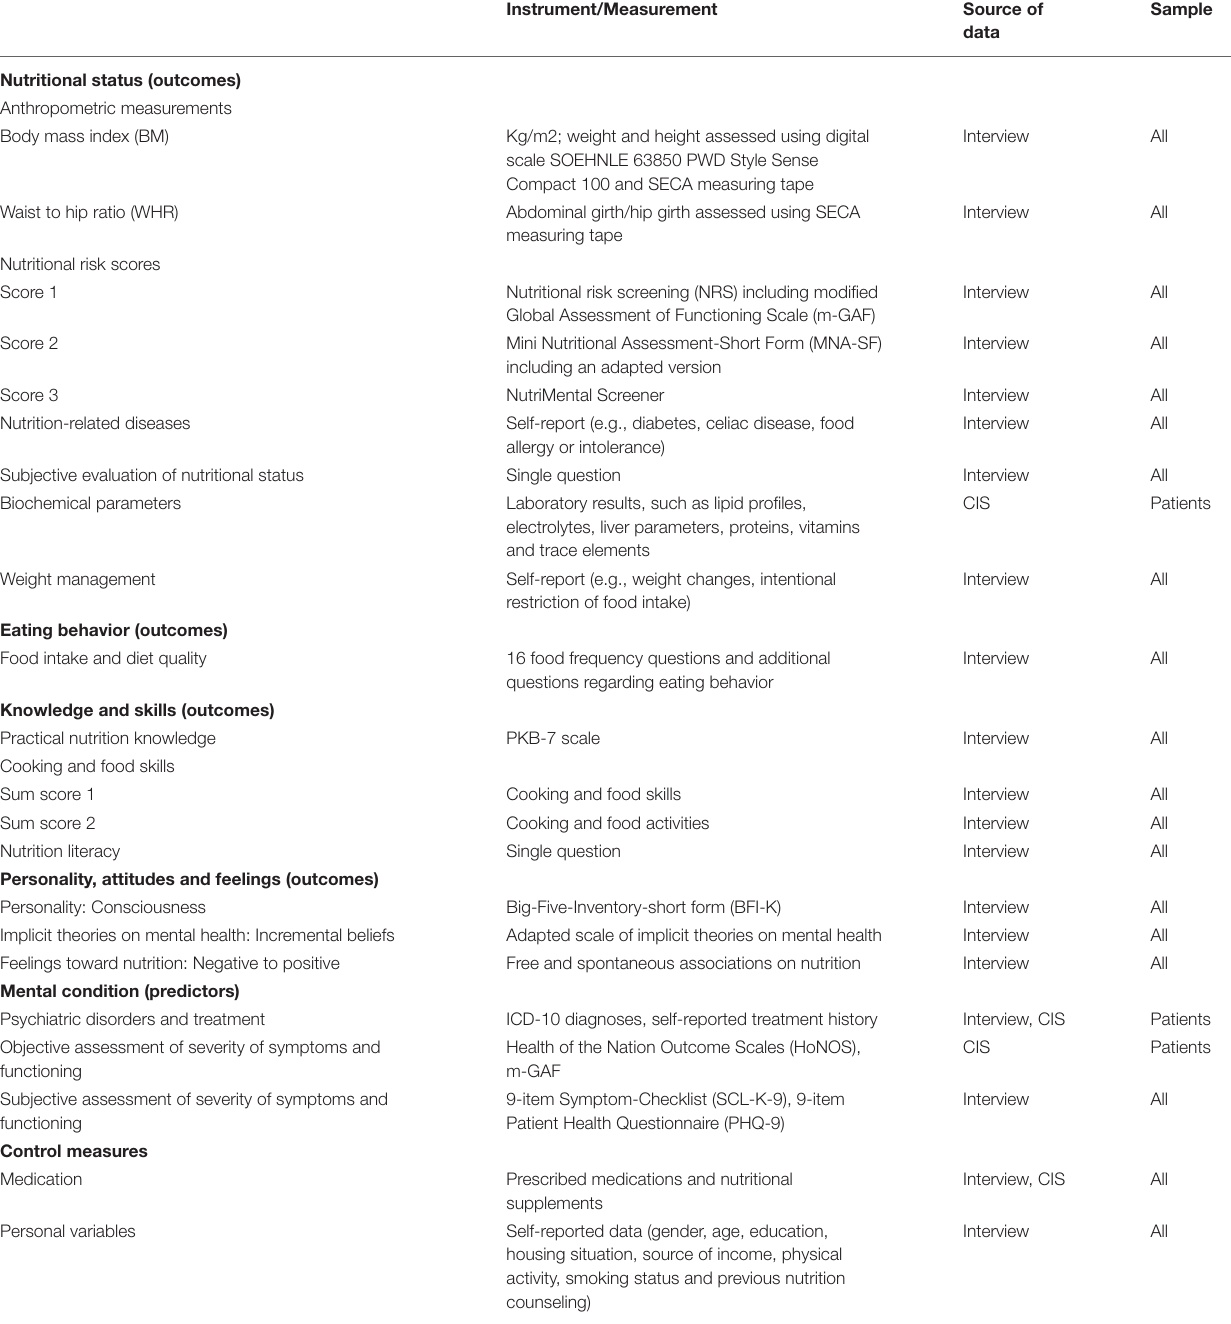
Instrument/Measurement Source of